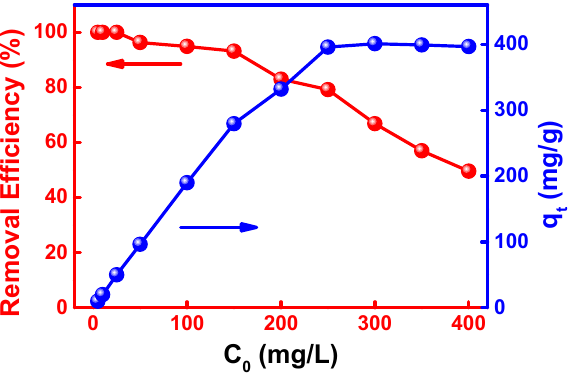
Figure 7. Effect of MB initial concentration on removal capacity for SPAC-8 with flow rate of 20 mL/min, solution volume of 10 mL and adsorbent dosage of 5 mg.